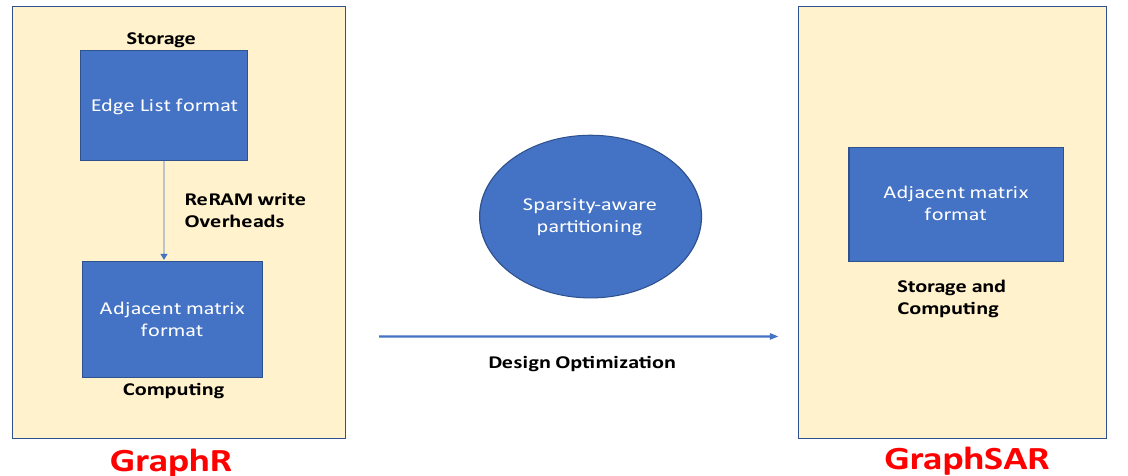
Figure 19. Contrast between GraphR and GraphSAR architectures [23].